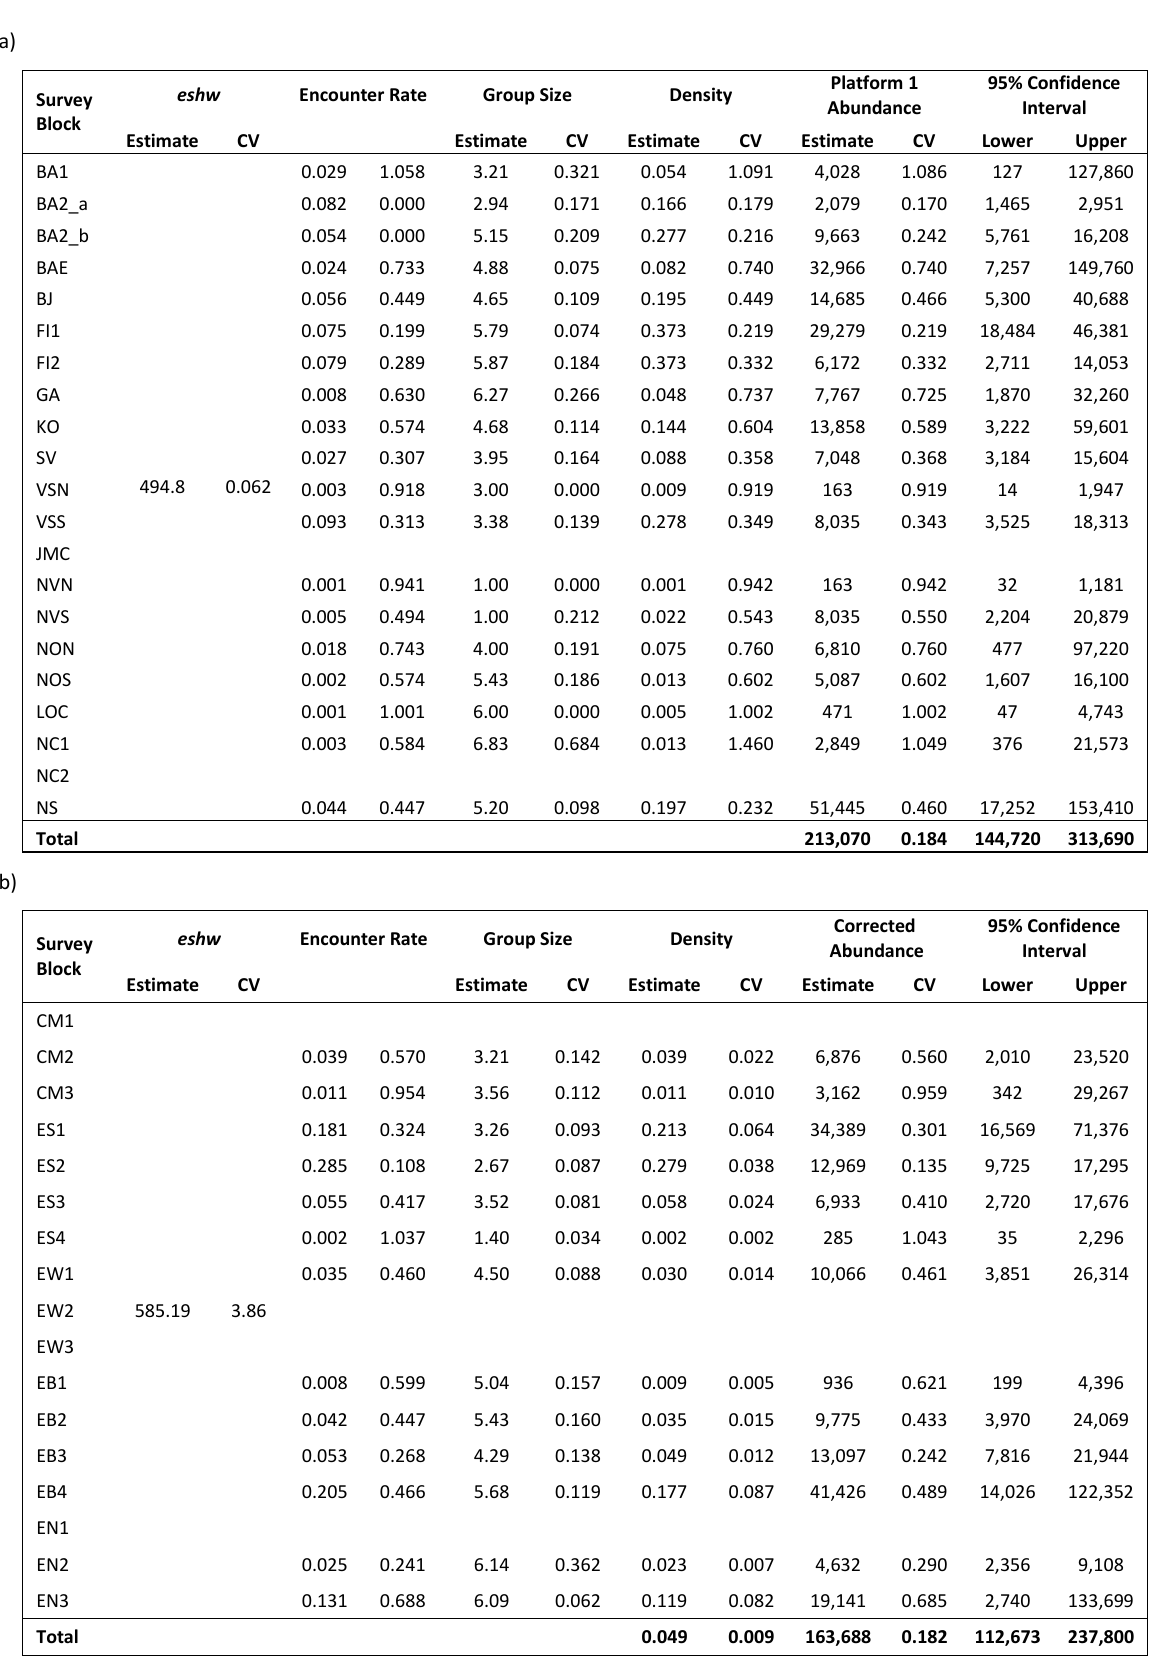
Table 11. Estimated density and abundance of Lagenorhynchus spp. for platform 1 from the 2002 – 2007 survey (a) and for the combined-platform data for the 2008 – 2013 survey (b). The eshw (effective search half width (m)) was estimated for the entire study area. Encounter rate, group size, density, abundance, and upper and lower confidence limits were estimated by